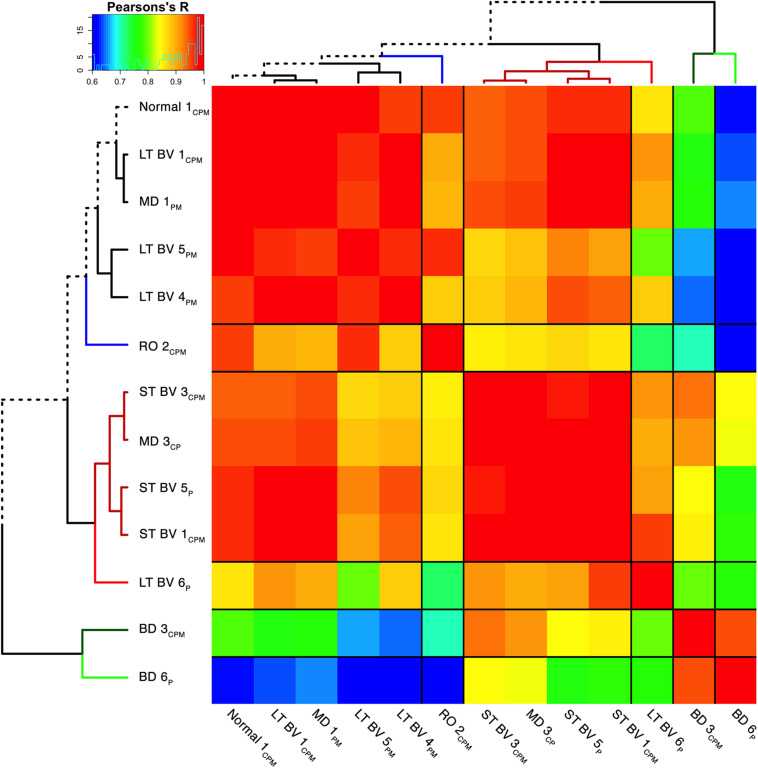
Visualizing pairwise correlations between recovery treatment subclusters. The matrix shows the strength of correlation (color) between the pairs of subclusters identified in the previous step [reproduced from Balsor et al. (2019b), used with permission]. Subclusters were ordered using hierarchical clustering to position subclusters with stronger correlations nearby in the matrix. This reordering identified five groups based on the height of the dendrogram branches and marked by different colored lines in the surrounding dendrogram. The solid black lines in the matrix mark the groupings of subclusters.